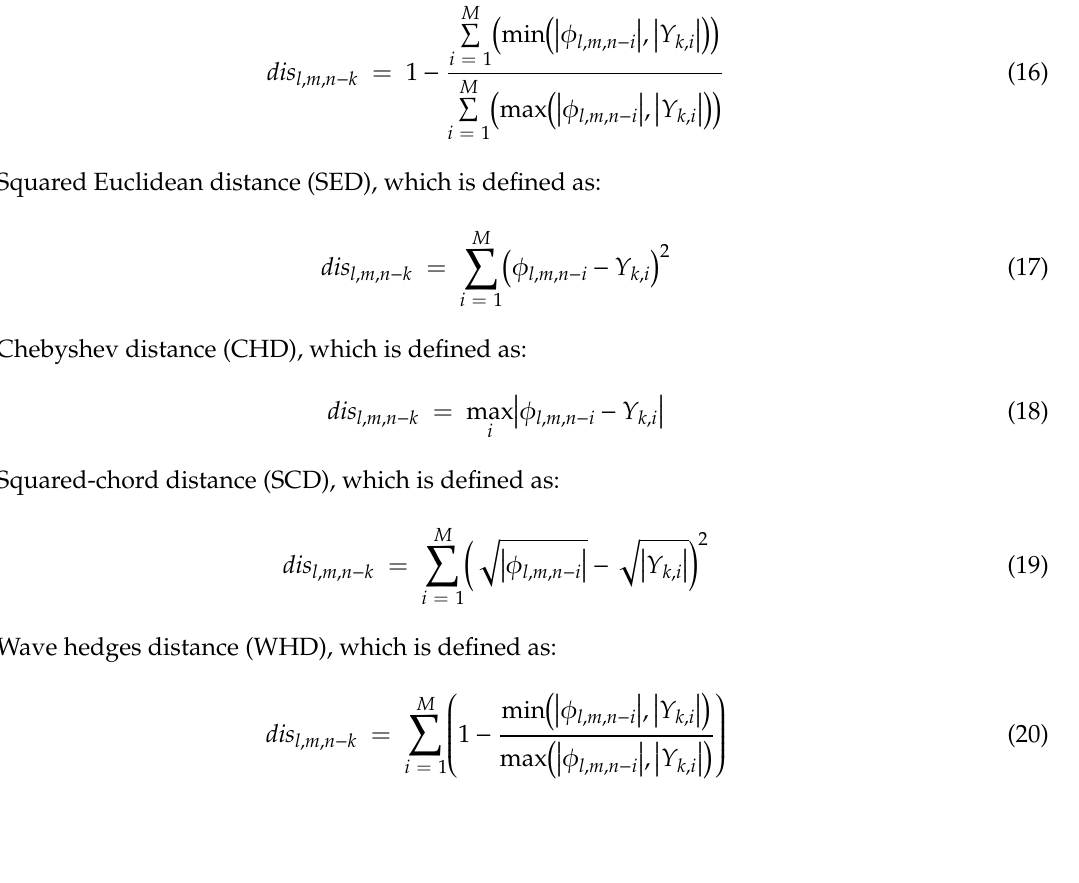
ARWKNN SAWKNN WKNN KNN